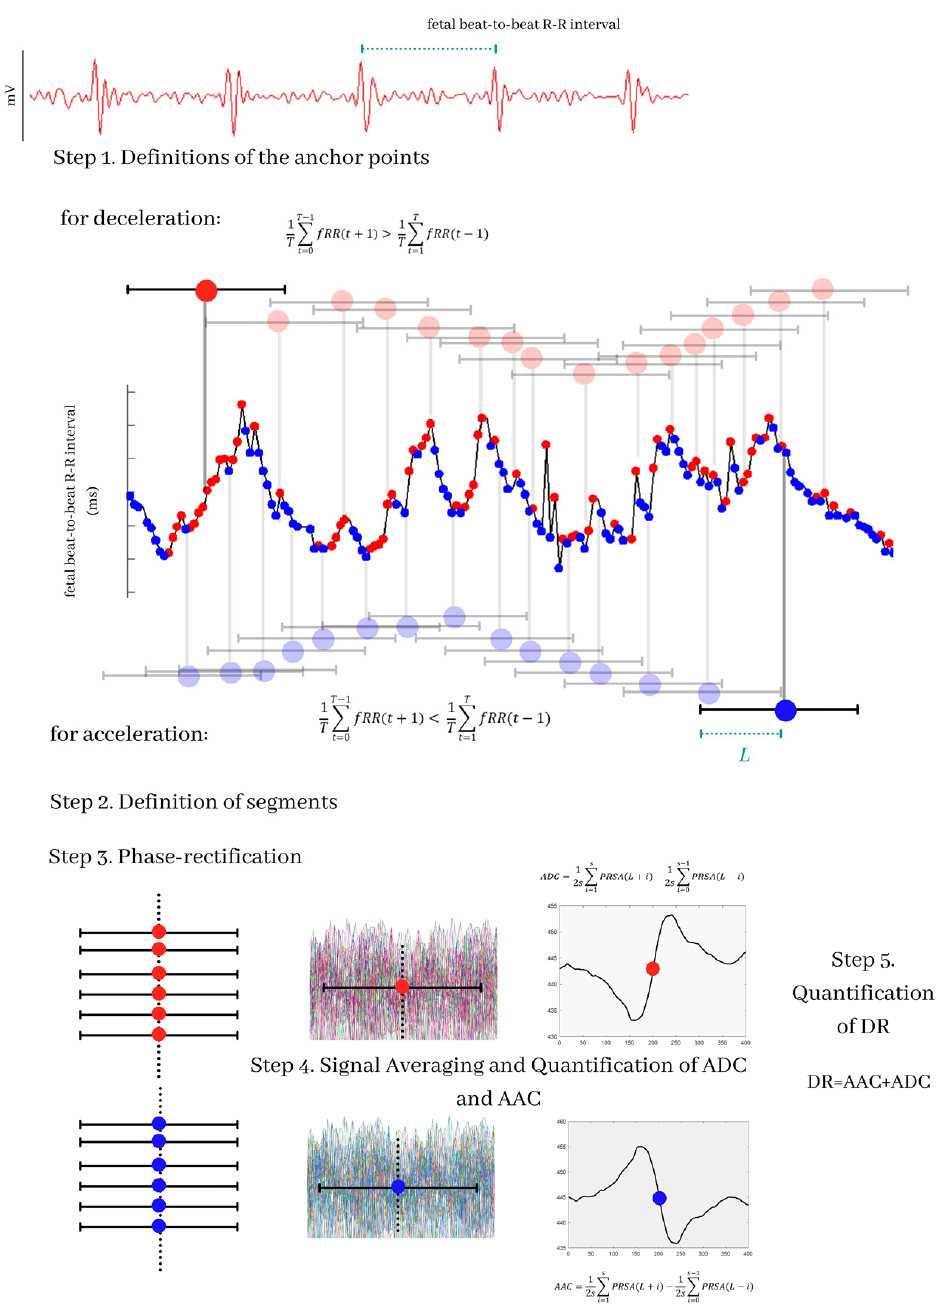
Figure 1. Description of the Phase-Rectified Signal Averaging ( PRSA ) algorithm and of the generation of the ADC , AAC , and DR indices. The transabdominal ECG signals are processed to obtain the fetal beat-to-beat R-R time series. The first step of the PRSA algorithm is the selection of the anchor points; in the figure, the anchor points for decelerations are marked with red points, and the anchor points for accelerations are marked with blue points; the selection of the anchor points depends on the parameter T . The second part of the algorithm is the choice of a time window covering each anchor point; this window measures 2 L . The next step of the algorithm is a phase-rectification; then, all the time windows are aligned and averaged with respect to the anchor points. This process provides the PRSA signal. The ADC and AAC values are the central point of the signal. Finally, DR values are calculated by the sum of AAC and ADC .